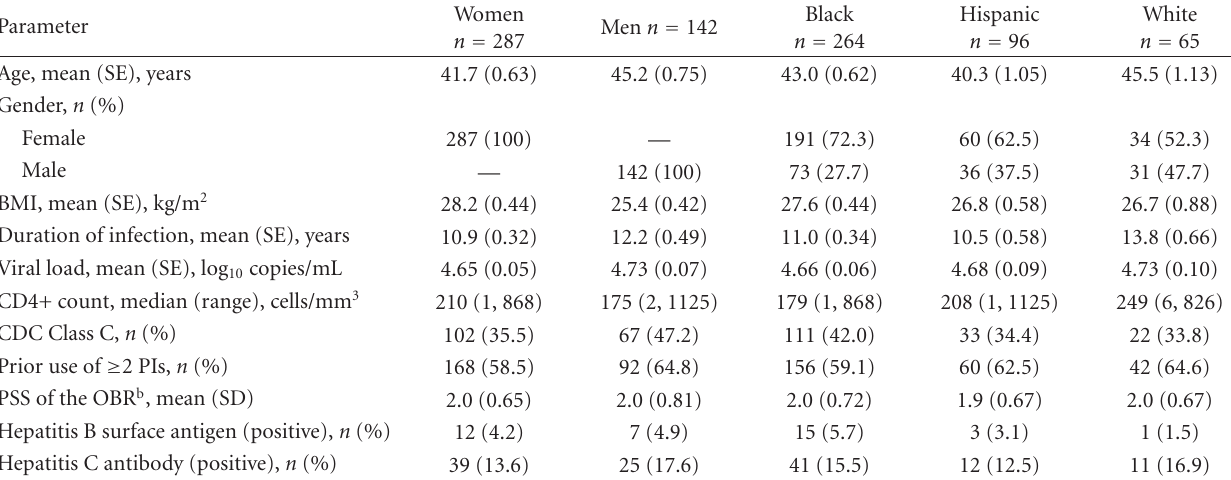
Table 1: Baseline demographics and disease characteristics by sex and race a .